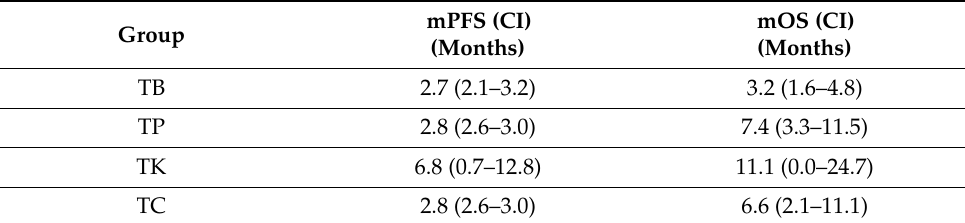
Table 1: TC1, TC6 and TB3) and two had one line (TC4 and TP1). The best